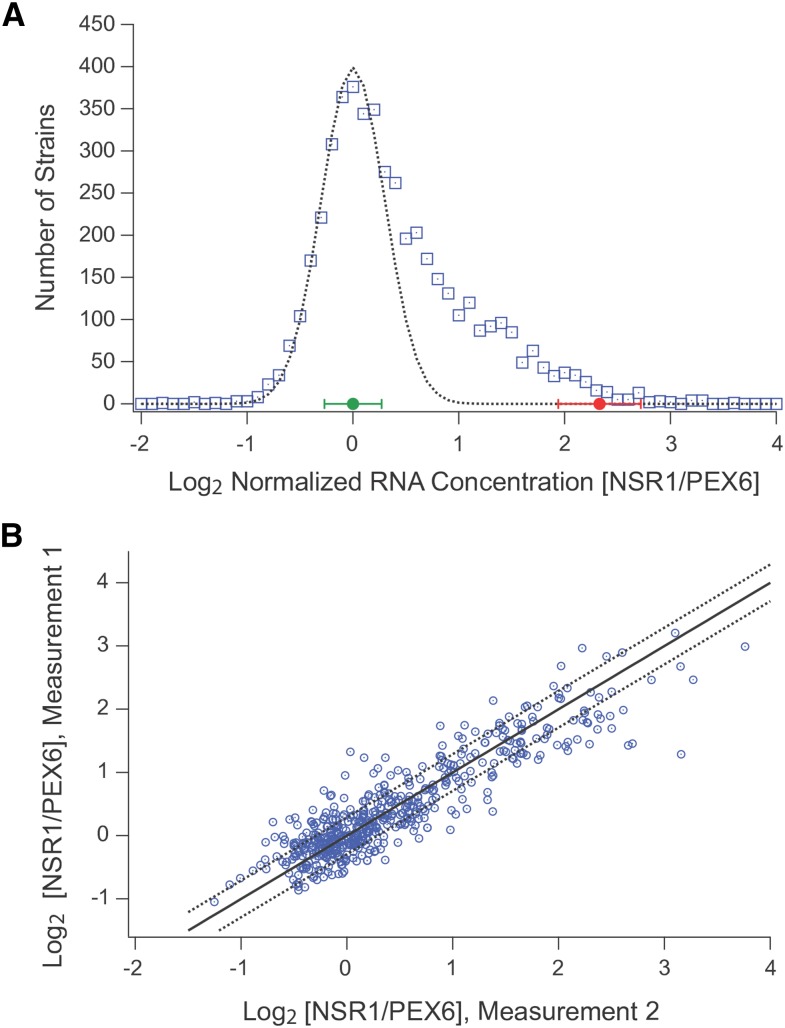
NSR1 expression levels for 4709 strains in the yeast knock-out collection. (A) Histogram showing the number of strains in the yeast knock-out library with log2 NSR1/PEX6 expression ratios ranging from –2 to 4 in 0.1 increment bins. All data were normalized to set the average expression ratio, minus the outliers, to 0.0 (see Materials and Methods). The green point and bar show the average and standard deviation of the NSR1/PEX6 ratio for the wild-type strain in stress (from Figure 3). The red point and bar shows the average and standard deviation of the NSR1/PEX6 ratio for the wild-type strain in mock stress (from Figure 3). The dotted line shows the fit to a normal distribution with an average signal of 0.0 and a standard deviation of 0.30. (B) Scatter plot showing the normalized NSR1/PEX6 expression values for 560 strains run through the automated pipeline on two separate weeks (usually more than a month apart). The solid line show the trend expected if there was a perfect correlation between datasets, the dotted line show the range expected for values that fall one standard deviation (0.3 log2 units) above or below this line.